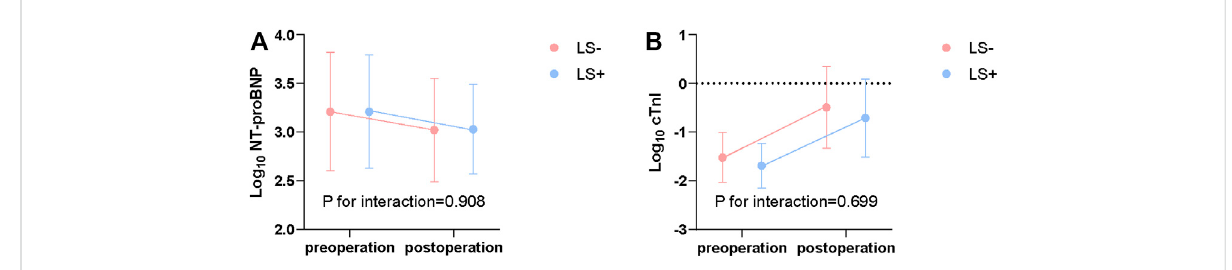
FIGURE 1 Log transformed NT-proBNP (pg/ml) (A) and cTnI (ng/ml) (B) before and after surgery. P for interaction from repeated measures ANOVA. NT- proBNP, N-terminal pro B type natriuretic peptide; cTnI, cardiac troponin I; ANOVA, Analysis of variance; LS+, Levosimendan group; LS-, Control group.